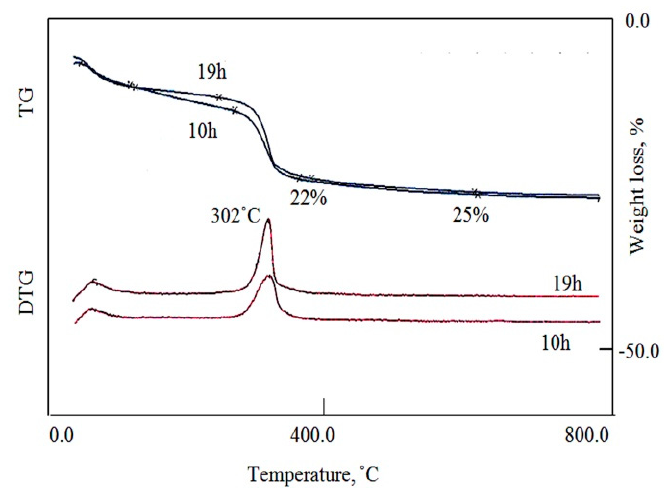
Figure 5. Thermal gravimetric (TG)and Differential thermal gravimetric (DTG) curves of Ni-Ti-4 LDHs at different reaction times.